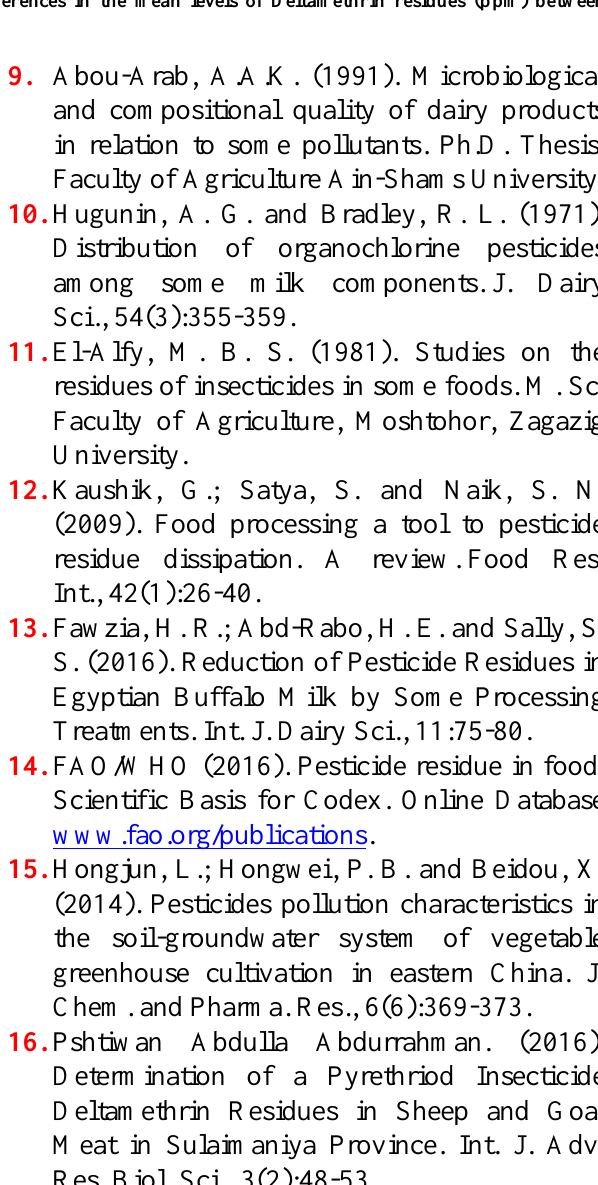
Table, 5: Seasonal variation of the mean levels of Deltamethrin residues (PPM) in raw milk samples of different animal species collected from Abu-Ghraib village. Source of No. of Summer milk samples examined Fat% samples Buffaloes Ewes Cows 5 Goats 5 Camels NV* LSD=0.02. Means in a column not followed by the same small letters revealed significant (p <0.05) differences between animal species. Horizontal different capital letters revealed significant (p<0.05) differences in the mean levels of Deltamethrin residues (ppm) between seasons. NV: No